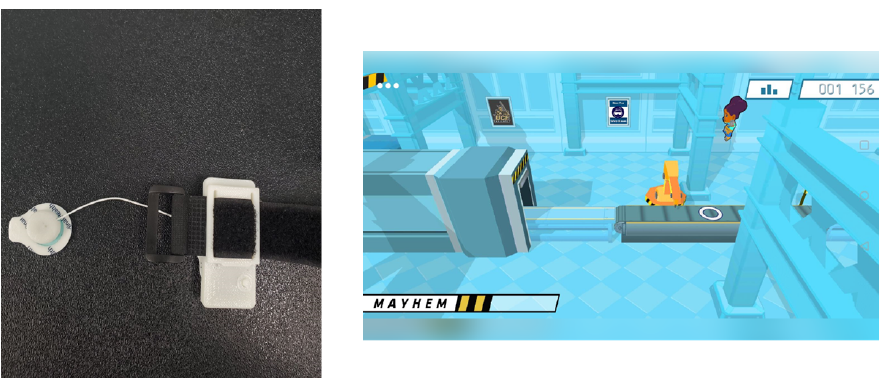
Figure 6. ( Left side ) Three-dimensional printed housing for electromyographic game controller, with interface surface electrode stickers and restraint. ( Right side ) In-game image of “Limbitless Runner” training game.